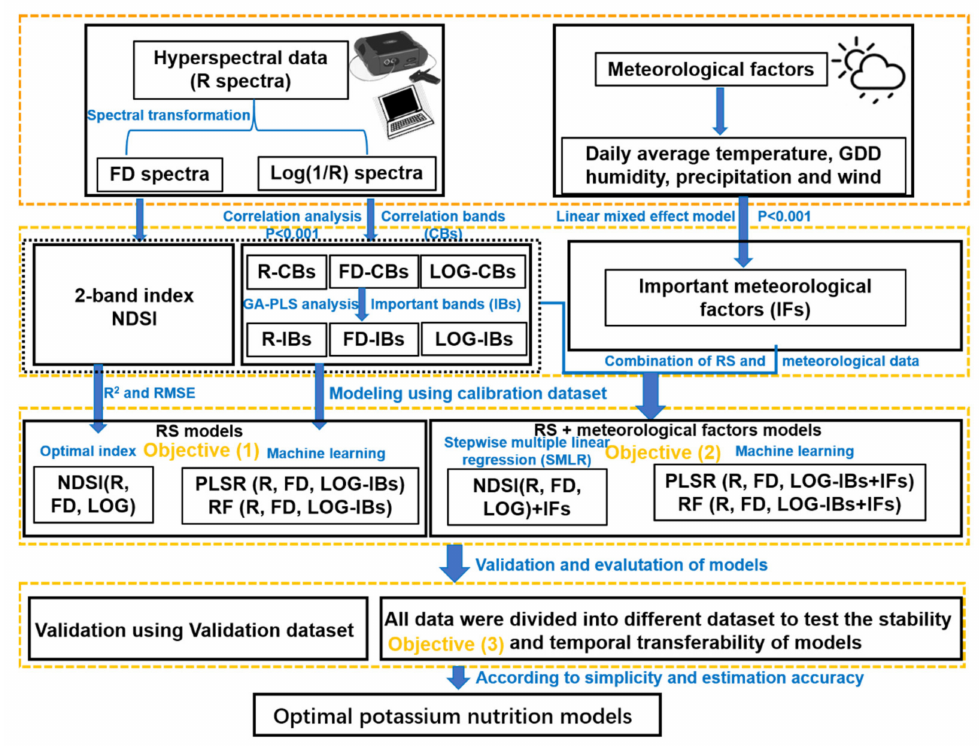
Figure 2. Workflow of the methodology used here to identify optimal remote sensing models for predicting rice PKC. Note: R = reflectance, FD = first derivative spectra, LOG = reciprocal logarithm-transformed spectra, NDSI = normalized difference spectral index, PLSR = partial least-squares regression, RF = random forest, GDD = growing degree day, and GA-PLS = genetic algorithms partial